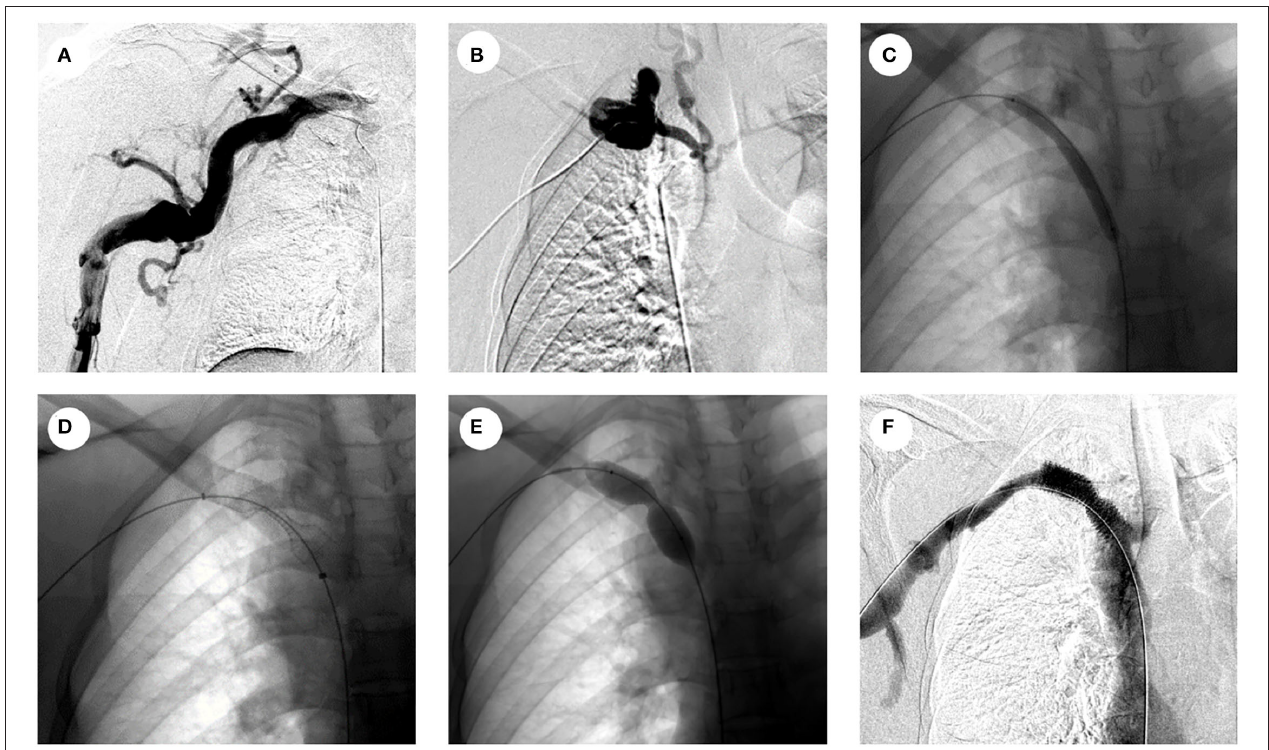
FIGURE 1 | Representative pictures of sharp needle recanalization of CVO. (A) Venography showing occlusion in the right brachiocephalic vein; (B) venography showing multiple side branches around the occlusion, sharp needle recanalization was performed after the failure of the conventional method; (C) venography showing PTA with 6-mm balloon after sharp needle recanalization; (D) venography after covered stent placement; (E) venography showing PTA with 14-mm balloon in the stenosis of a covered stent; (F) venography shows significant improvement in the stenosis of the covered stent after PTA and unobstructed blood flow in the covered